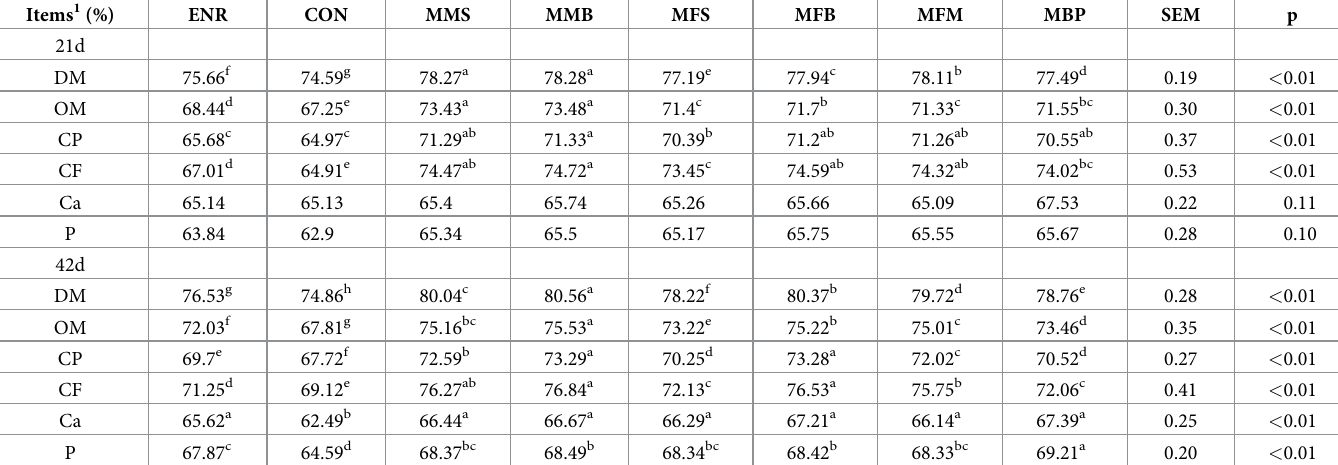
Table 3. Effects of dietary nonantibiotic alternative growth promoter combinations on the utilization of dry matter (DM), organic matter (OM), crude protein (CP), crude fat (CF), calcium (Ca), and phosphorus (P) in broiler chicks at 21 and 42 days. Items 1